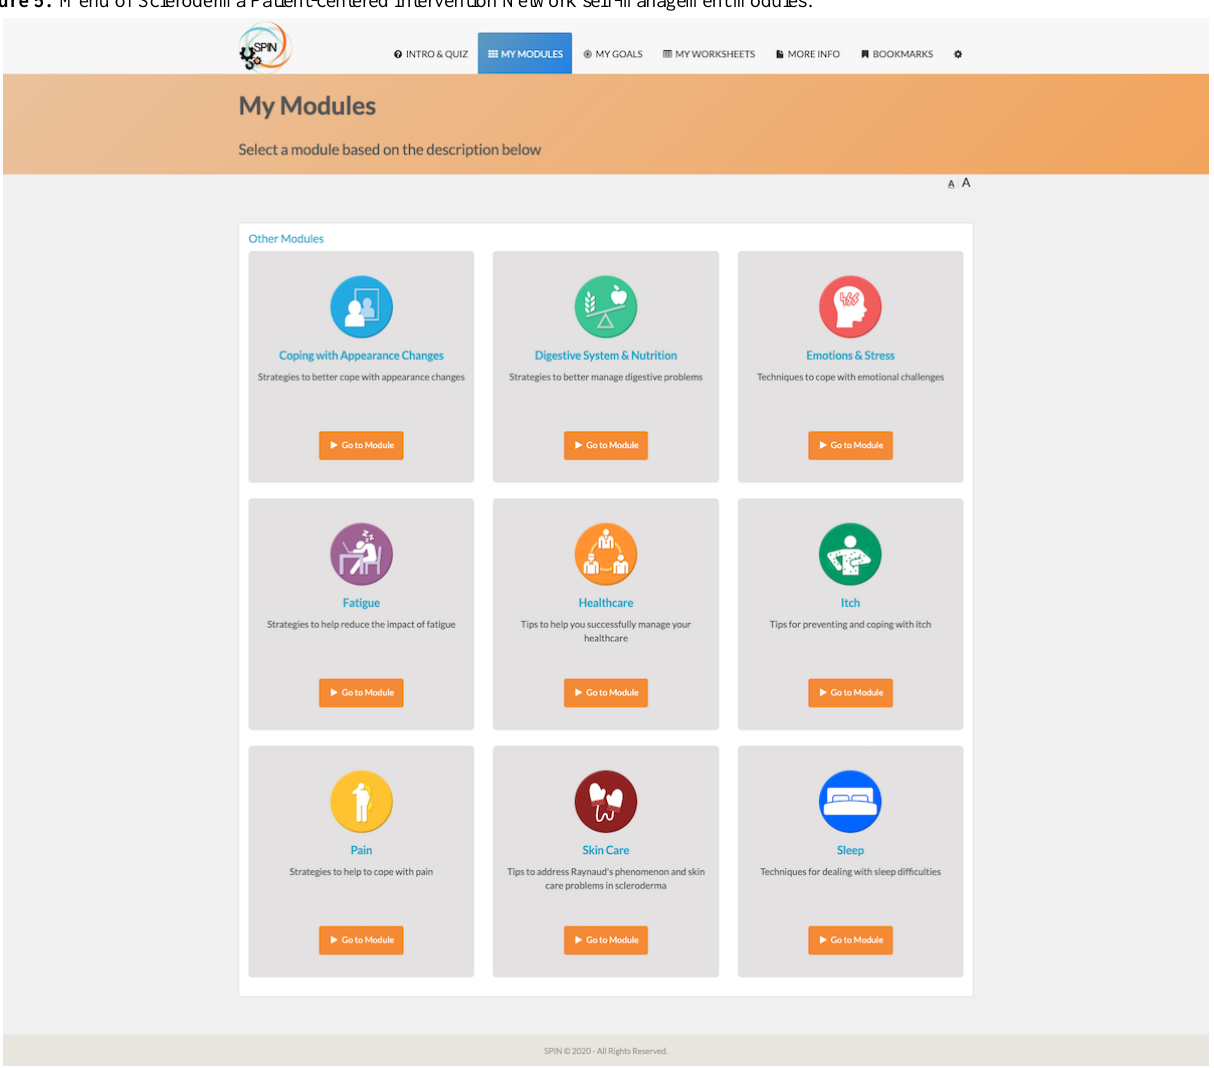
Figure 5. Menu of Scleroderma Patient-centered Intervention Network self-management